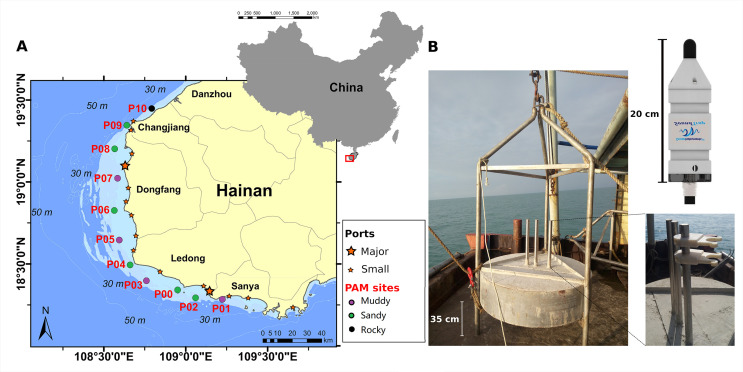
Map of the study area and monitoring sites (A) and picture of the acoustic platform (B). Monitoring sites are marked with ○, and different colors means different types of seabed. The major ports and other ports are marked with ☆. The SoundTrap recorder was fixed on a stainless steel column at the center of each platform.